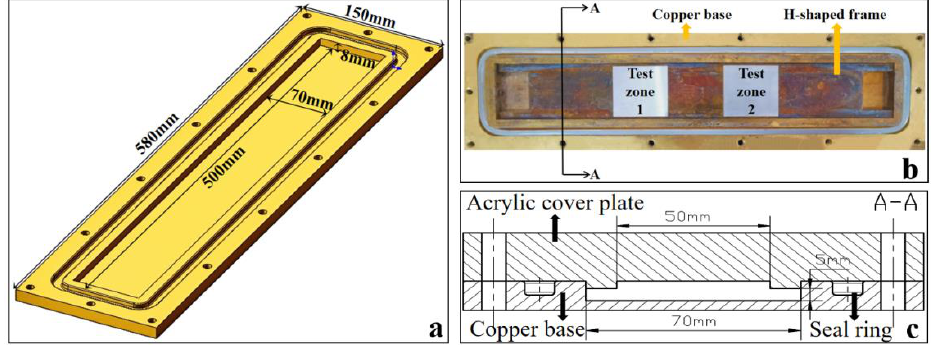
Figure 4. Size of the flow channel. ( a ) The size of the external of base and the inner area of the flow passage; ( b ) H-shaped frame; ( c ) The size of the cross-sectional area of the flow test section.